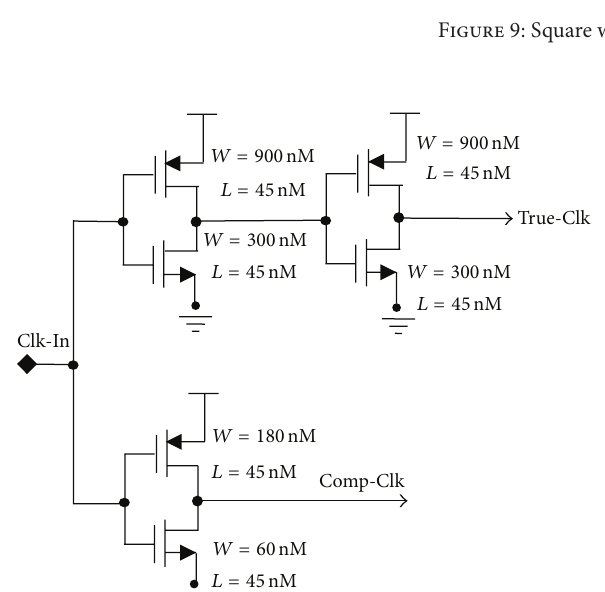
Figure 9: Square wave input at 6.135 GHz.